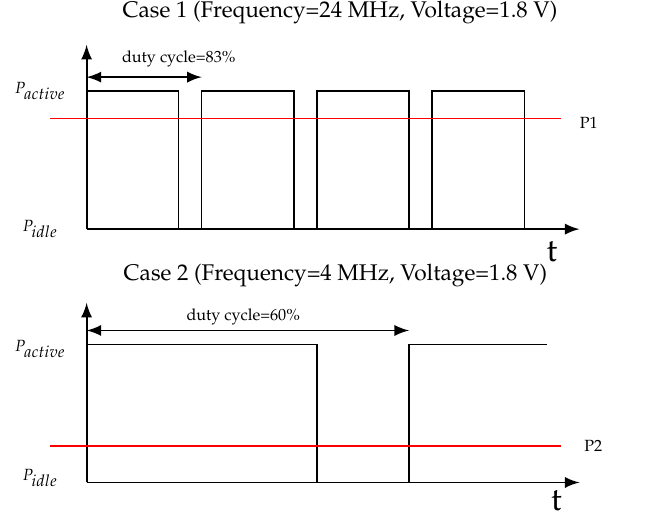
Figure 13. Operating frequency versus power efficiency (P1 and P2 are the average consumed power for high frequency and low frequency,